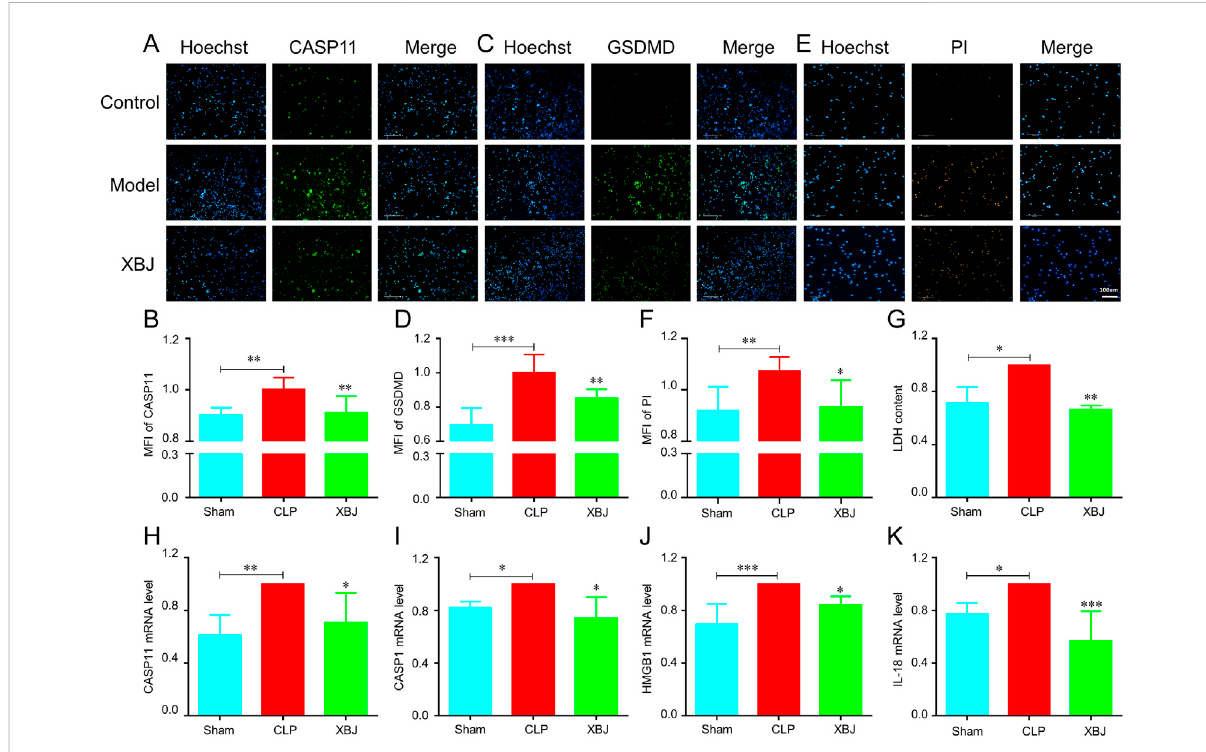
FIGURE 7 Invitro ,XBJreducedtheexpressionsofGSDMD-relatedgenes.Thepuri fi edneutrophilsfrombonemarrowwerestimulatedwith1.5 ug/mlLPS and 2.5 mM ATP and then incubated with or without XBJ (A – F) . The representative images and quanti fi ed results of caspase-11 (A,B) immuno fl uorescent staining, GSDMD (C,D) immuno fl uorescent staining, and PI staining (E,F) in the control, model, and XBJ treated groups (G) . The relative LDH expression in different groups of neutrophils (H – K) . The relative mRNA expressions of NETosis-related markers, caspase-11 (H) , caspase-1 (I) , HMGB1 (J) , and IL-18 (K) in neutrophils, were determined by real-time PCR. All experiments were repeated at least three times. The values were indicated as mean ± SD. * p < 0.05, ** p < 0.01, *** p < 0.001, compared with the Model